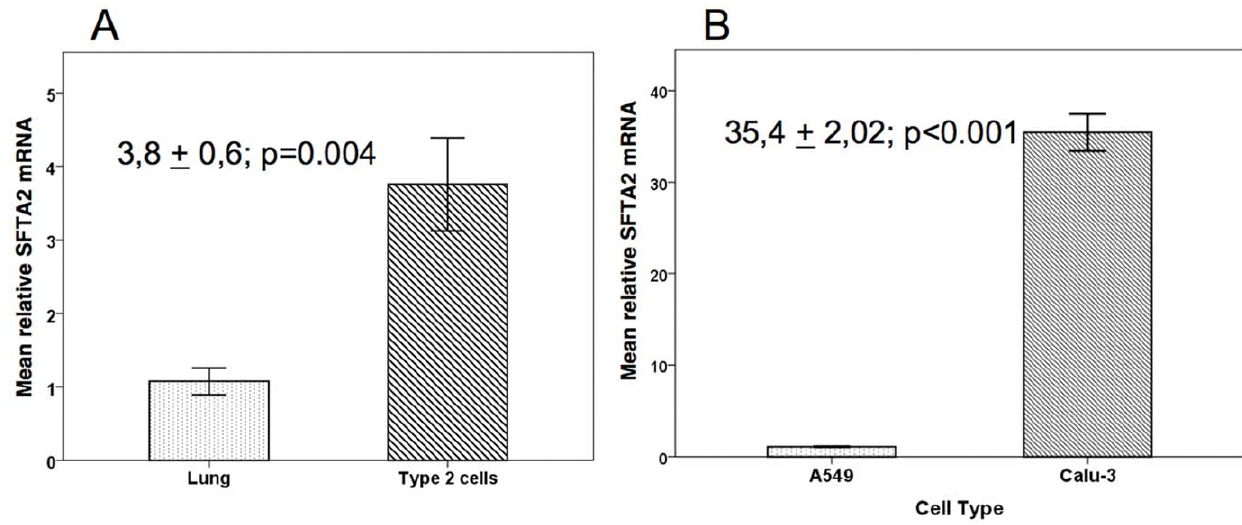
Figure 6. Quantitative RT-PCR-analysis of SFTA2 mRNA. Relative abundance was set to 1 for lung tissue and A549 cells respectively. A. Isolated mouse type II cells demonstrated a 3.8 fold enrichment of SFTA2 messenger RNA compared to total lung tissue. B. SFTA2 mRNA is 35.4 times more abundant in Calu-3 cells than in A549 cells. While A549 human adenocarcinoma cells show some characteristics of Type II cells, Calu-3 is an airway adenocarcinoma cell line that expresses submucosal gland cell features.